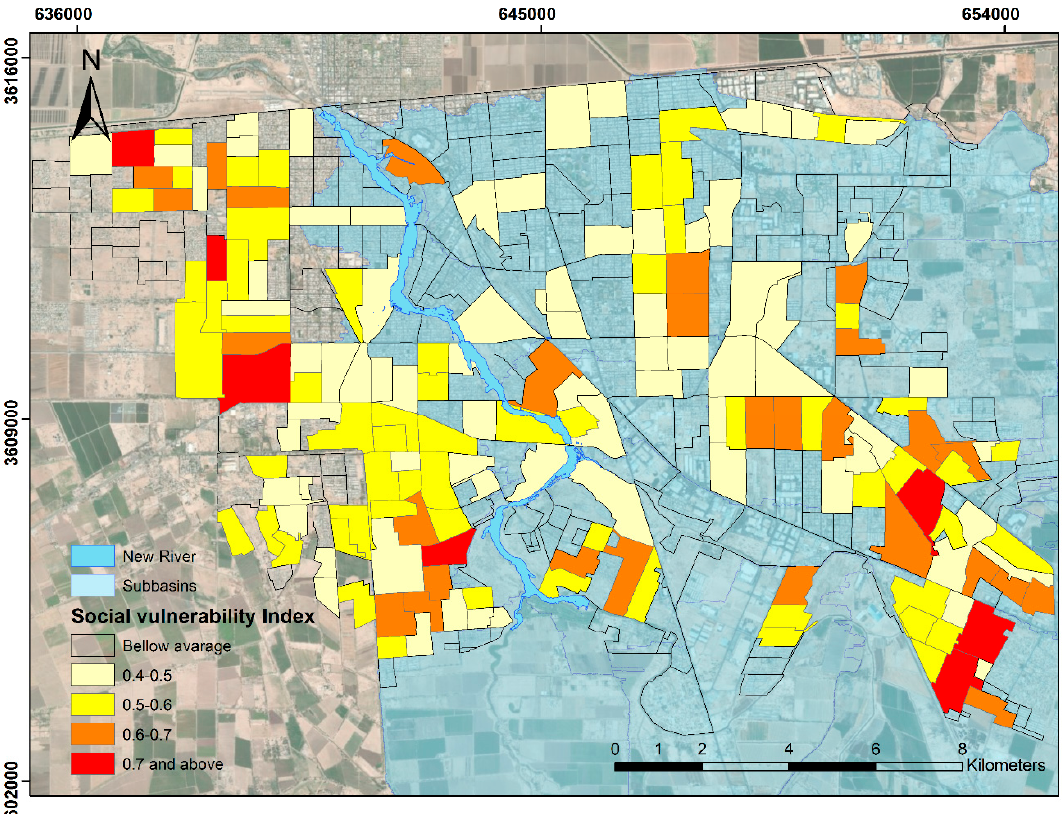
Figure 3. Social vulnerability values for the studied AGEB.